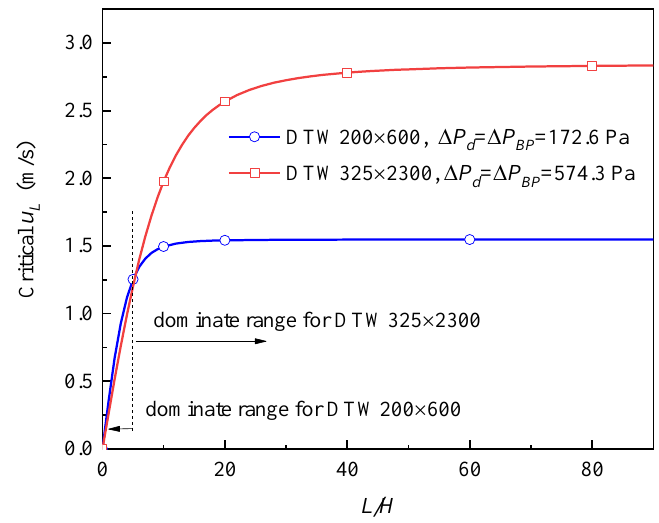
Figure 5. Critical outflow velocity versus the L/H of the channels.